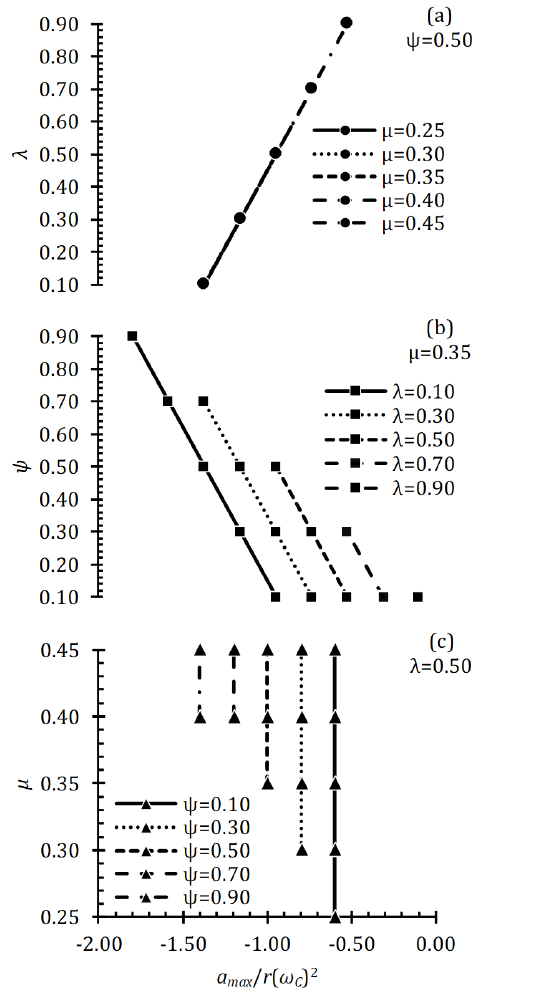
Figure 8. Effect of λ , ψ and µ on a max . Figure 9. Effect of λ , ψ and µ on s avg